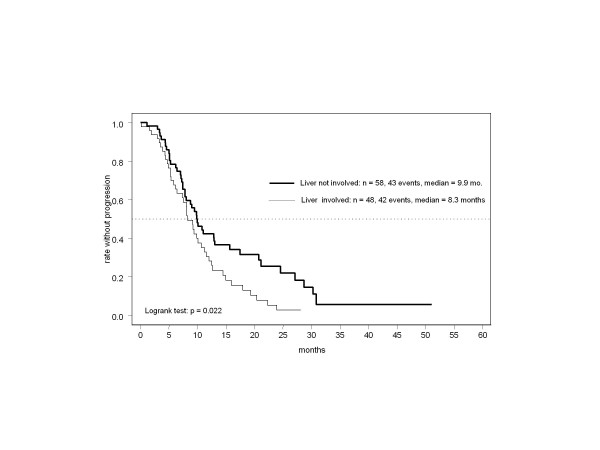
Time to progression by hepatic involvement.